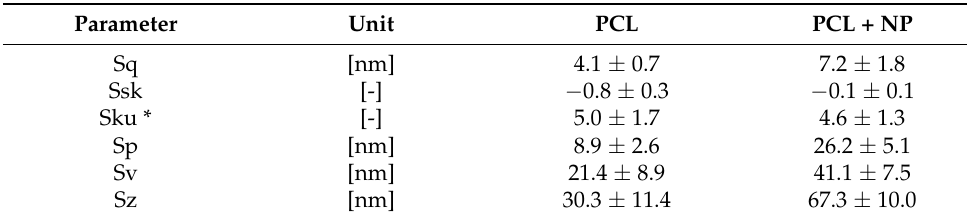
Figure 5. Top-view and 3-D rendering of high resolution (450 × 450 nm 2 ) representative AFM micrographs of the ( a ) PCL–fiber and ( b ) MIM– β CP. Table 1. Height distribution parameters obtained from the analysis of representative AFM images of the samples, according to ISO 25178-2:2012